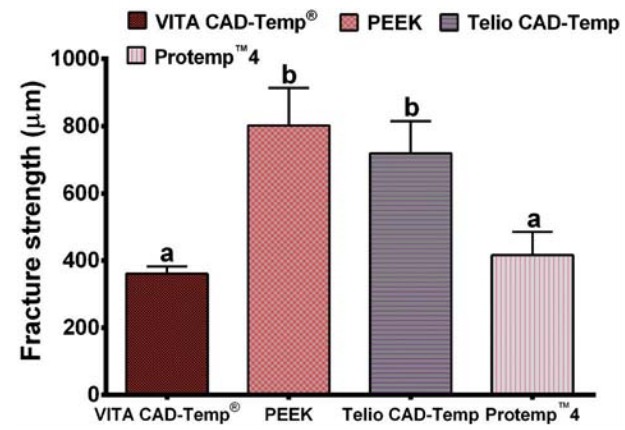
Bar graph showing the mean values and standard deviation (SD) of the fracture strength for each group of material. Means with the same letter are not significantly different. Means with different letters are significantly different